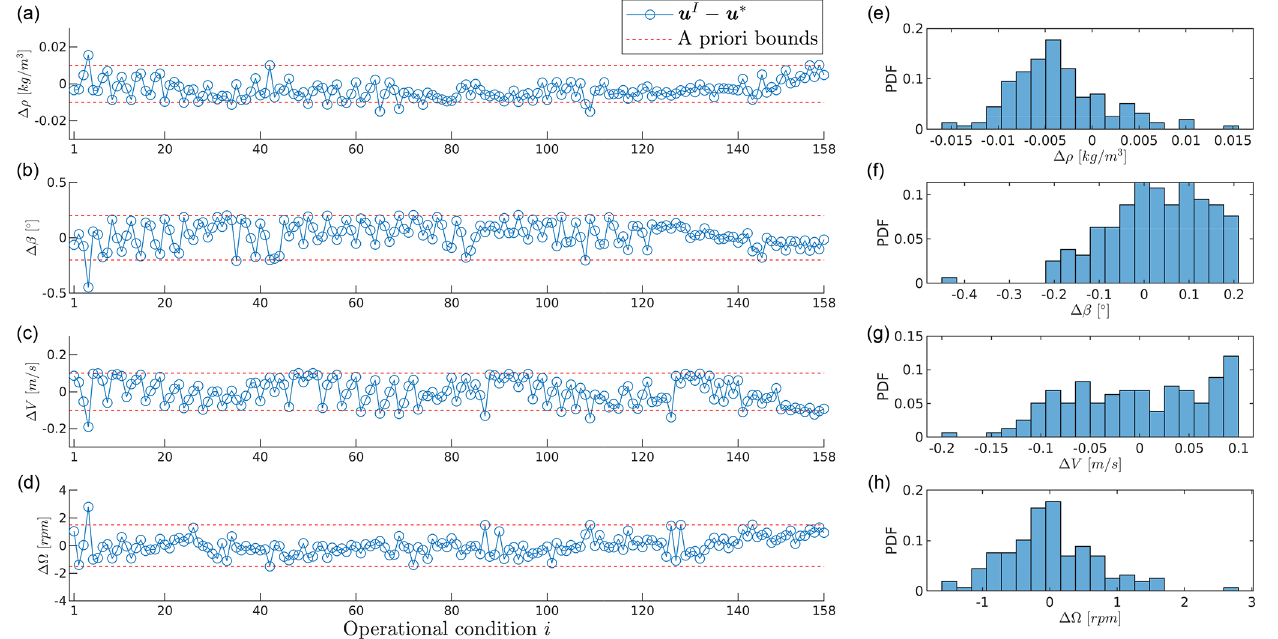
Figure 4. Differences between identified and nominal inputs for all operating conditions (a–d) and their corresponding distributions (e–h) . (cid:113) σ T = (cid:98) R 22 = 0 . 023 .